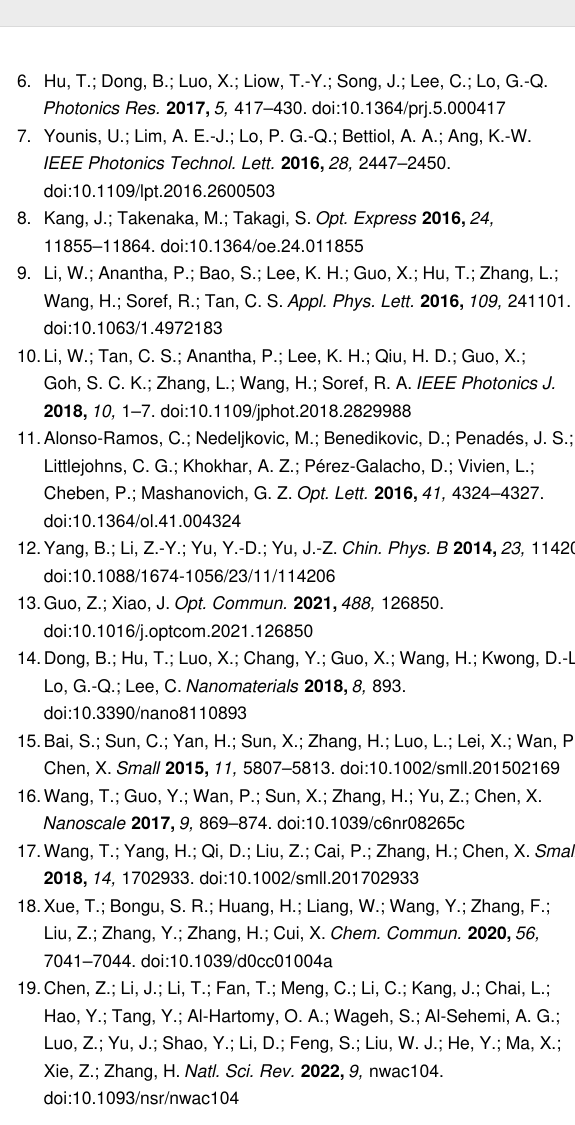
Figure 6: Sensing performance of the proposed MIR FGC.